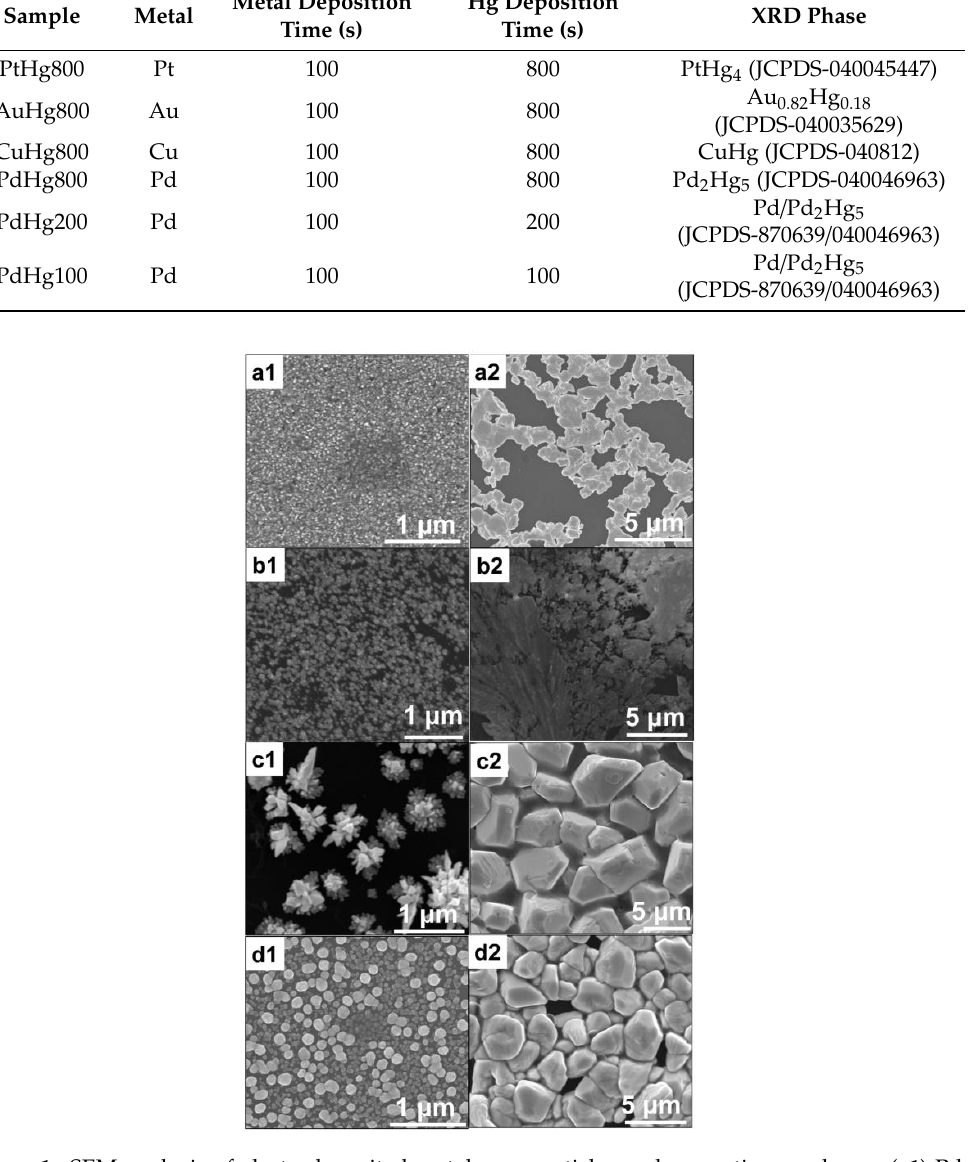
Figure 1. SEM analysis of electrodeposited metal nanoparticles and respective amalgams ( a1 ) Pd, ( b1 ) Pt, ( c1 ) Au, ( d1 ) Cu, and electrodeposited Hg on the metal nanoparticles ( a2 ) PdHg800, ( b2 ) PtHg800, ( c2 ) AuHg800 and ( d2 ) CuHg800.